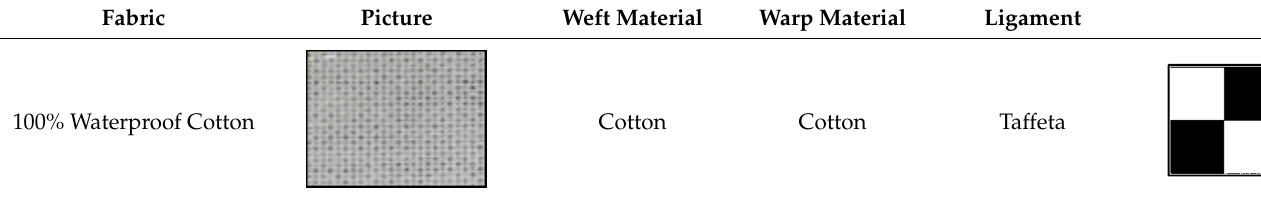
Table 1. Fabric characteristics (I): composition and ligament.